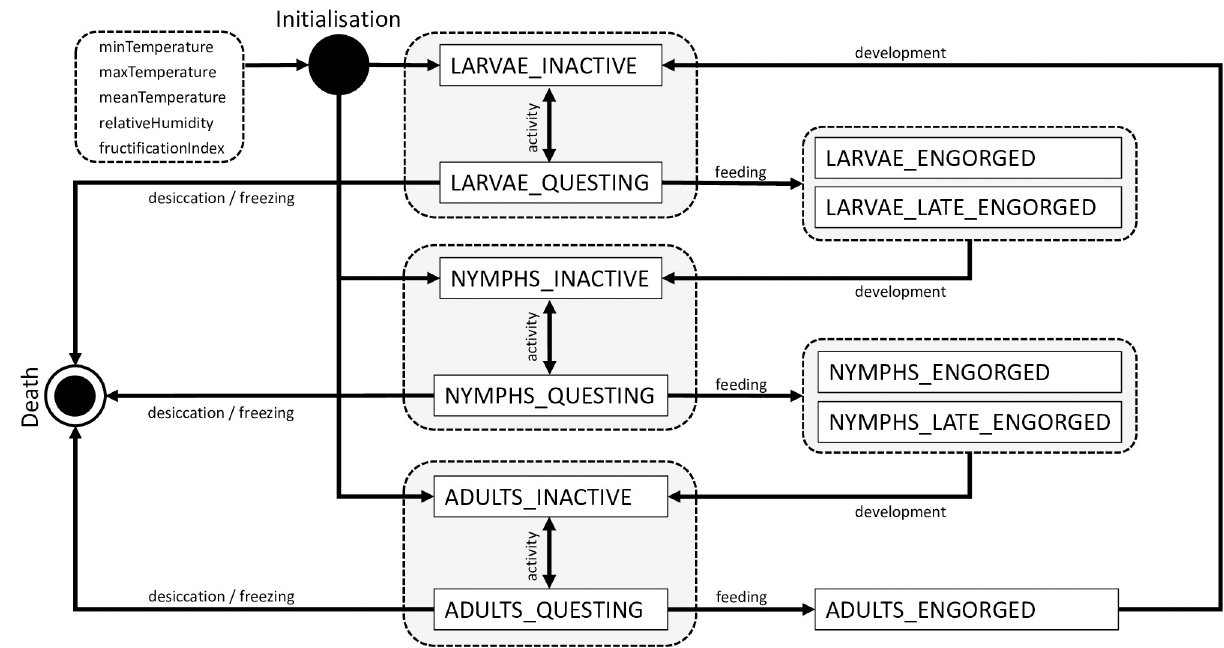
Fig 1. State transition diagram of the IRIS model (Ixodes RIcinus Simulator). The model simulates the development process of I . ricinus from larvae to nymph to adult stages forced by climate conditions. The white boxes represent the model cohorts. The black arrows indicate the transition between cohorts, which is controlled by the respective model process indicated by its